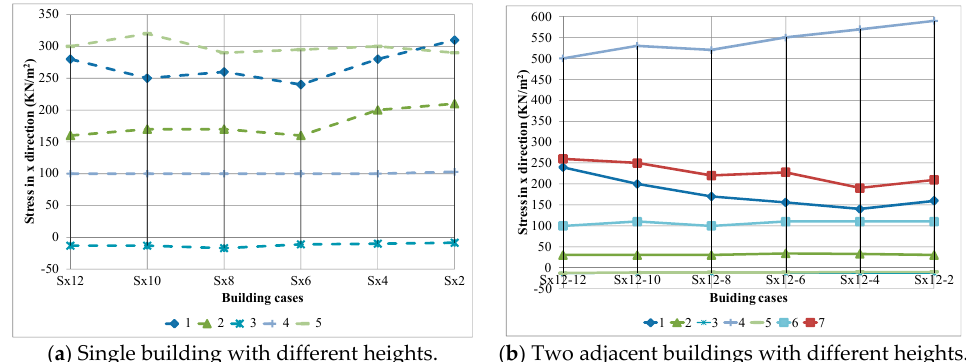
Figure 10. Stress in the soil in x direction around the foundation of the single and adjacent buildings.